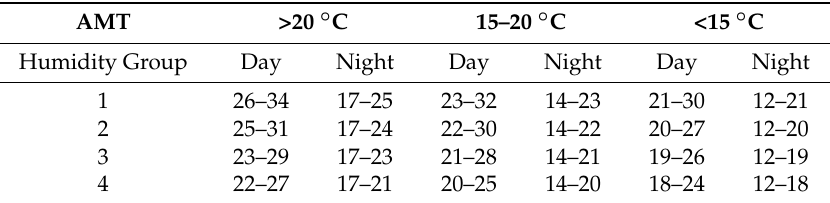
Table 8. Comfort limit. AMT, Annual Mean Temperature.